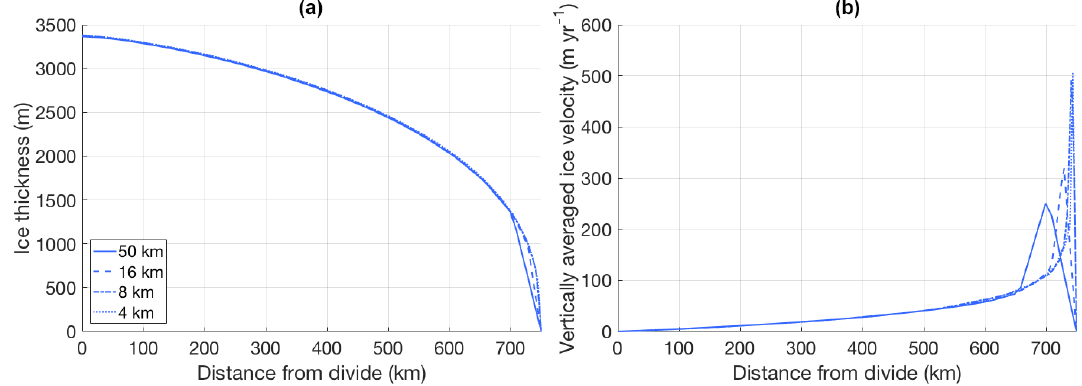
Figure 5. (a) Ice thickness and (b) vertically averaged ice velocity of a radial transect of the ice sheet in experiment IV, simulated by UFEMISM at 50, 16, 8, and 4km ice-margin resolutions. The sharp peaks in the velocity near the margin are a result of the singularity in these Nye–Vialov margins, and the ice thickness approaches zero as one approaches the margin, but the ice flux remains finite, implying an infinite